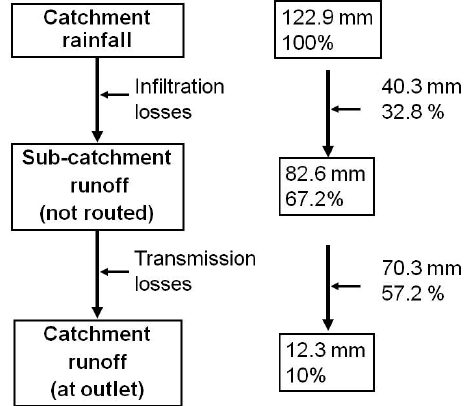
Fig. 13. Modelled infiltration and transmission losses for the 2010 flash